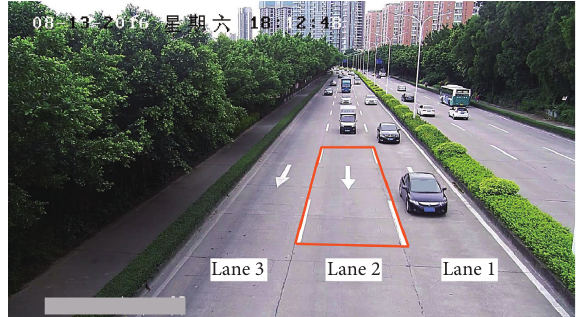
Figure 16: The calibration rectangle pattern in a key frame and the definition of lane